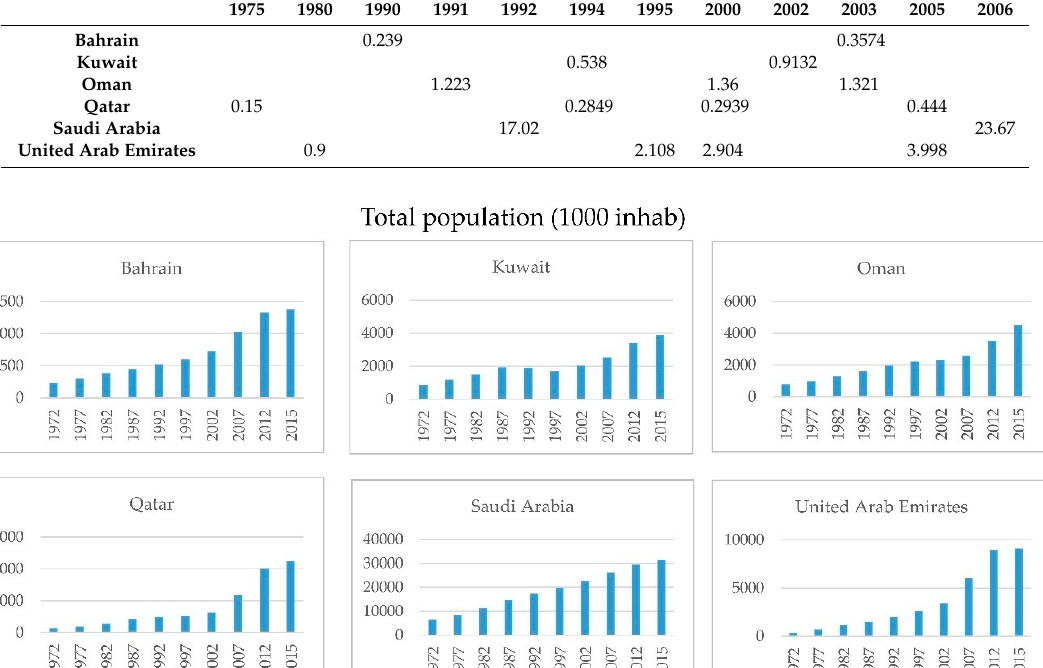
Figure 2. Demographic and resource-use growth in the GCC countries (based on data from the World Bank, FAO & FAO AQUASTAT). 3.3. Scale and Planning Alongside the supply system’s configuration (coupling between elements) and dimension (size of the boundaries), the planning scale (quantity and size of elements) constitutes an important risk factor. A supply system with few elements performing large tasks might be more vulnerable to supply interruptions and systems failures. On the other hand, a large degree of decentralization produces complexity, as it increases the number of actors, suppliers, and regulators. If not governed effectively, such decentralization can impede control, coordination, and planning. For example, decentralization of energy infrastructure might require polycentric governance and a great deal of